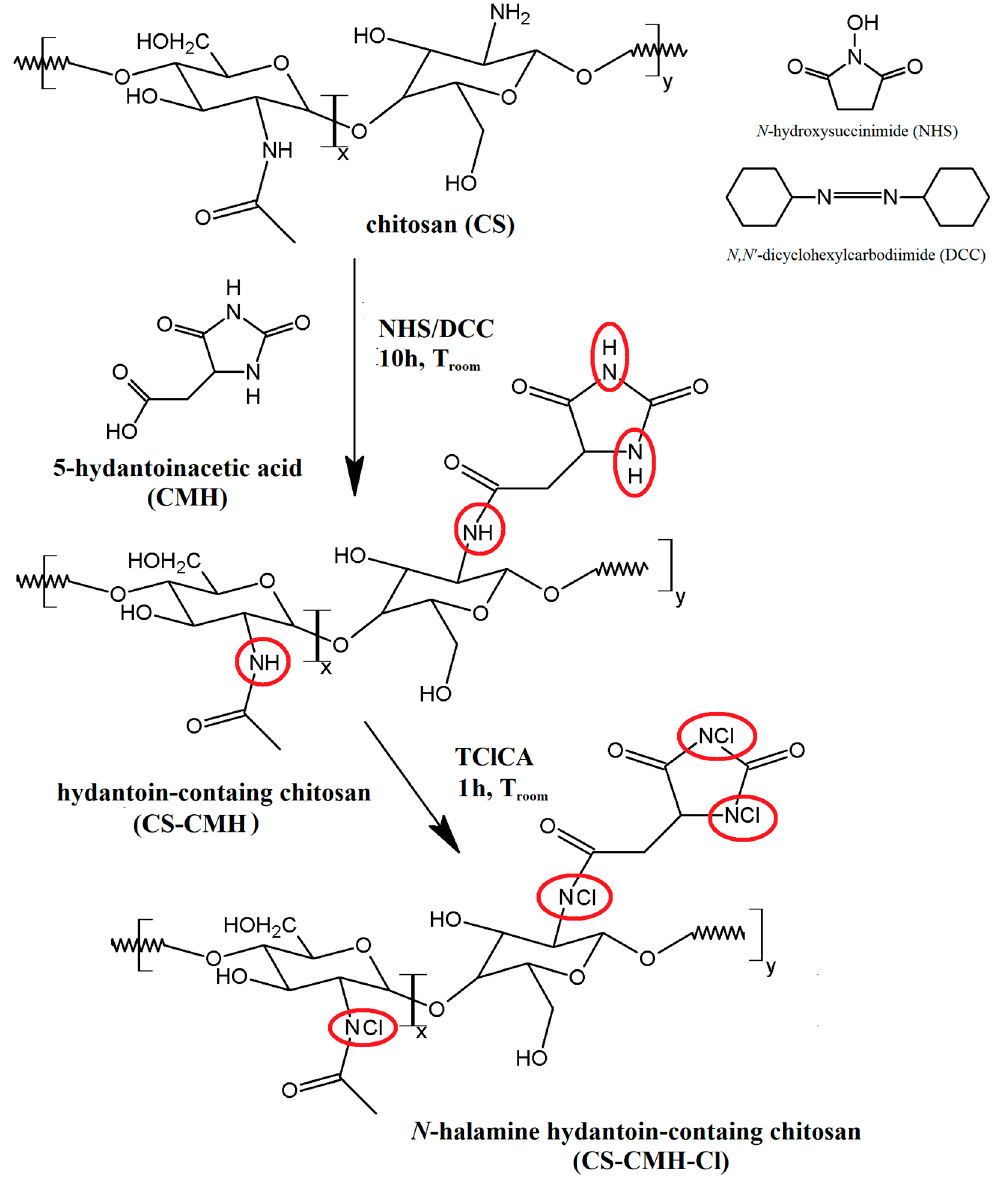
Figure 1. Preparation of the hydantoin-containing chitosan (CS-CMH) and N -halamine hydantoin-containing chitosan (CS-CMH-Cl). Active groups marked by circles.